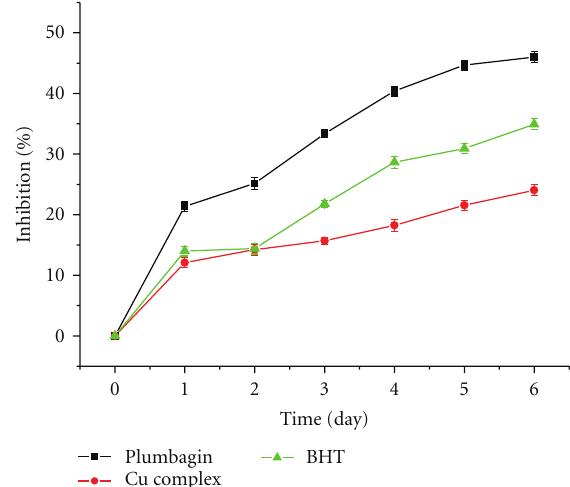
Figure 4: Lipid oxidation inhibition by plumbagin, Cu (II) com- plex, and BHT in peanut oil in di ff erent reaction times (1, 2, 3, 4, 5, and 6